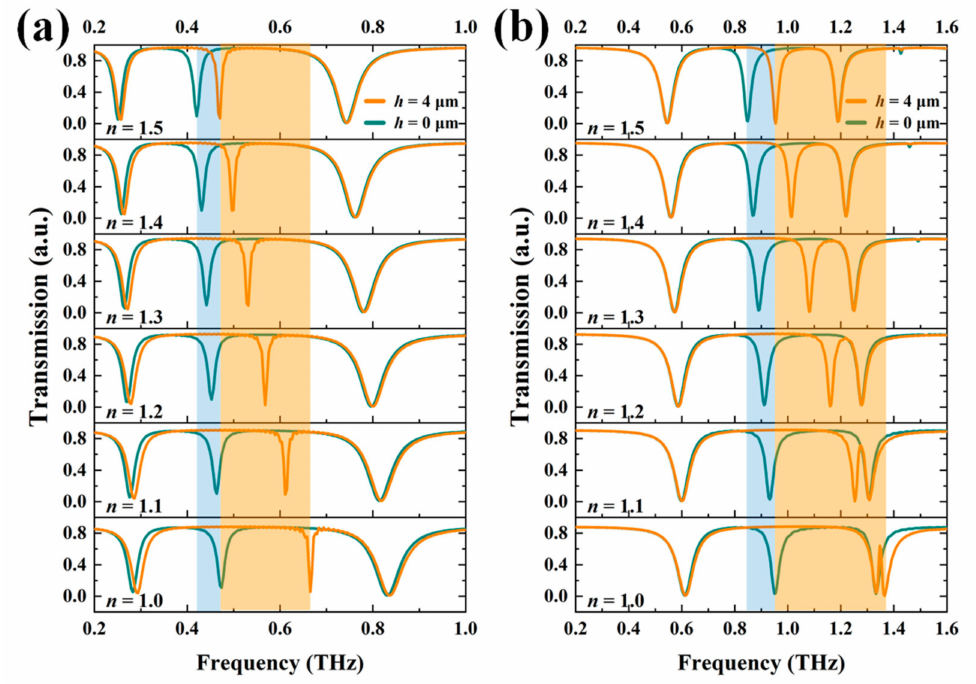
Figure 8. Transmission spectra of ( a ) TTM-1 and ( b ) TTM-2 with different n values when h = 0 µ m and h = 4 µ m. The blue and orange area are the resonant shifts when h = 0 µ m and h = 4 µ m,